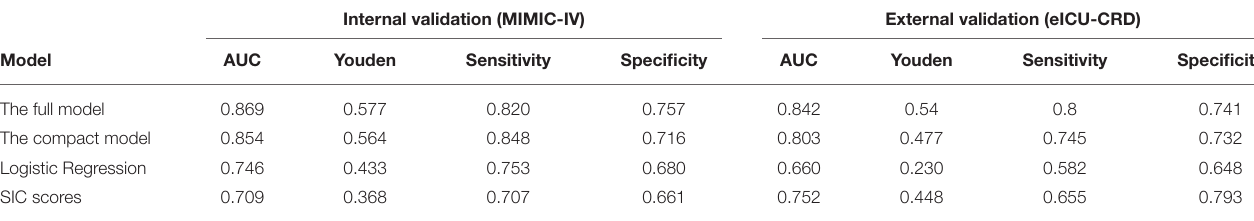
TABLE 2 | Performance of the final models and SIC scores in internal and external validations.